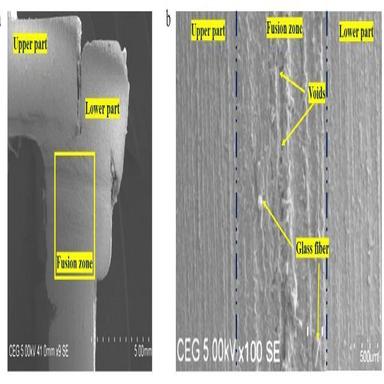
SEM image (a) one side cut section of welded sample (b) near fusion zone.